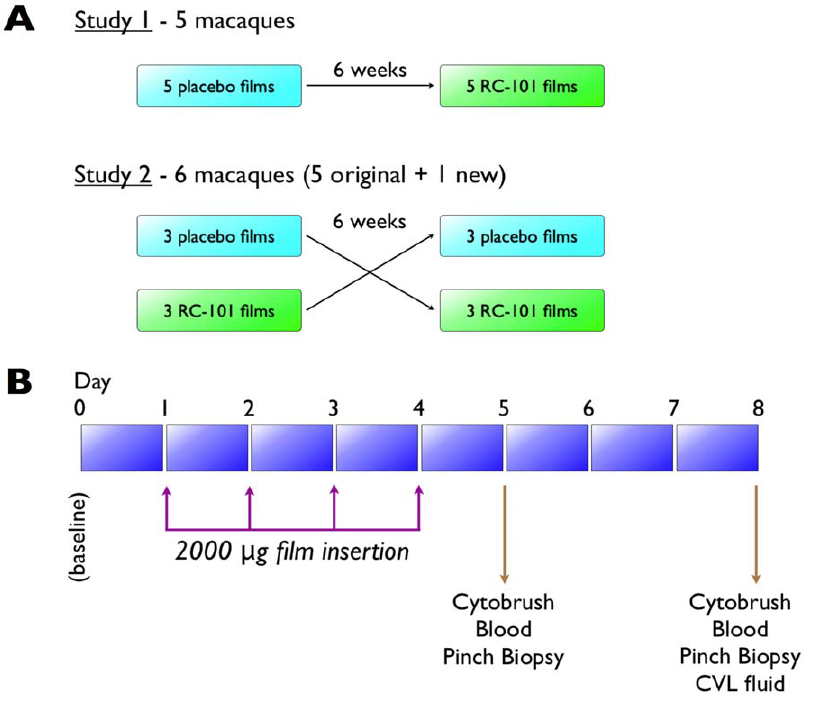
Figure 2. Invivo study protocol in pigtailed macaques. ( A ) Two studies were performed. The first included five macaques, in which each monkey received placebo films followed six weeks later with RC-101 films. The second study included the five original macaques plus an additional monkey, in which half received RC-101 films and half received placebo films. Six weeks later, each monkey receiving the opposite film type. ( B ) Baseline measurements for colposcopy, vaginal pH, and microflora were obtained at day 0. At days 1–4, RC-101- or placebo-containing films were instilled intravaginally. At days 5 and 8, cytobrushes, blood, and pinch biopsies were obtained, and at day 8 CVL fluids were obtained from each monkey.